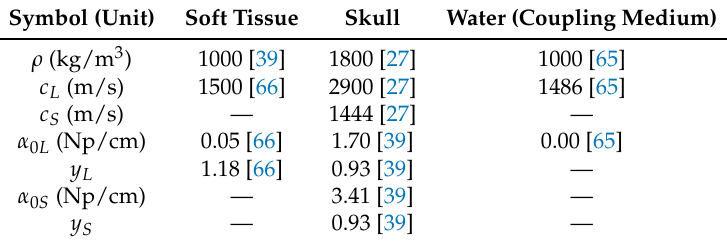
Table 1. Acoustic properties used in the